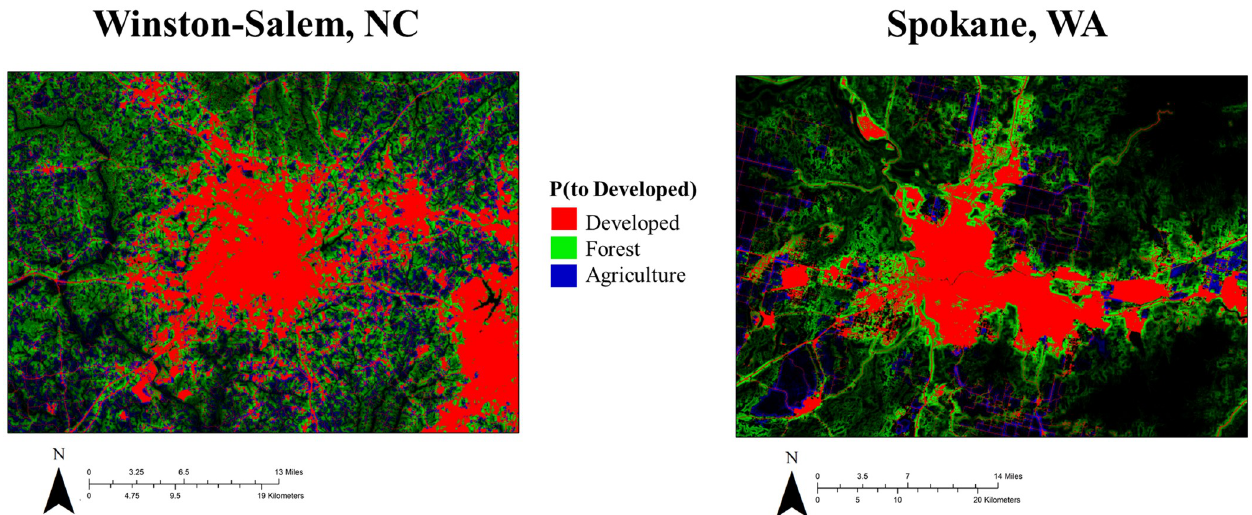
Fig 6. Transition probability rasters. Example probability rasters of transitions to the Developed land use class from Developed (red), Forest (green), and Agriculture (blue) land use classes. The probability of transitioning from Developed to Developed is set at 1, so the red pixels are intended here as a convenient reference to previously existing Developed